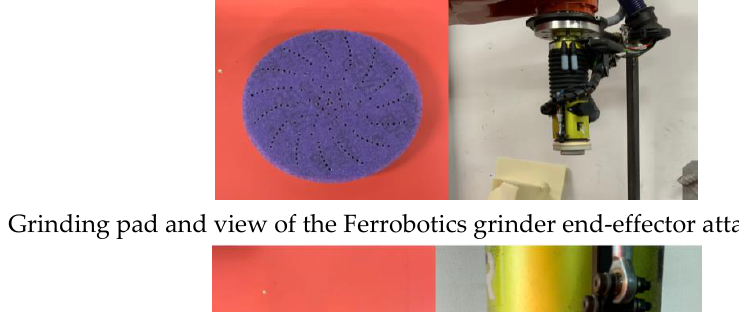
Figure 9. Main components of reconditioning cell during integration testing.